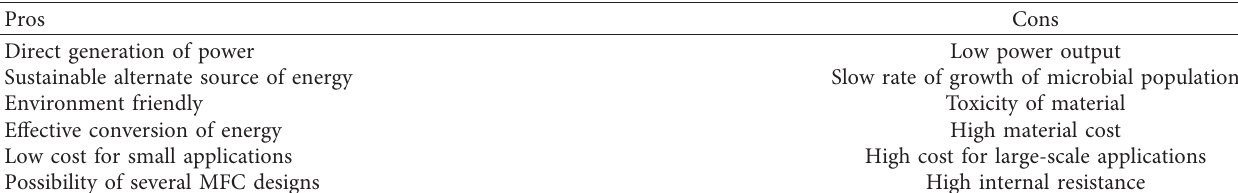
Table 1: Pros and cons of MFCs.